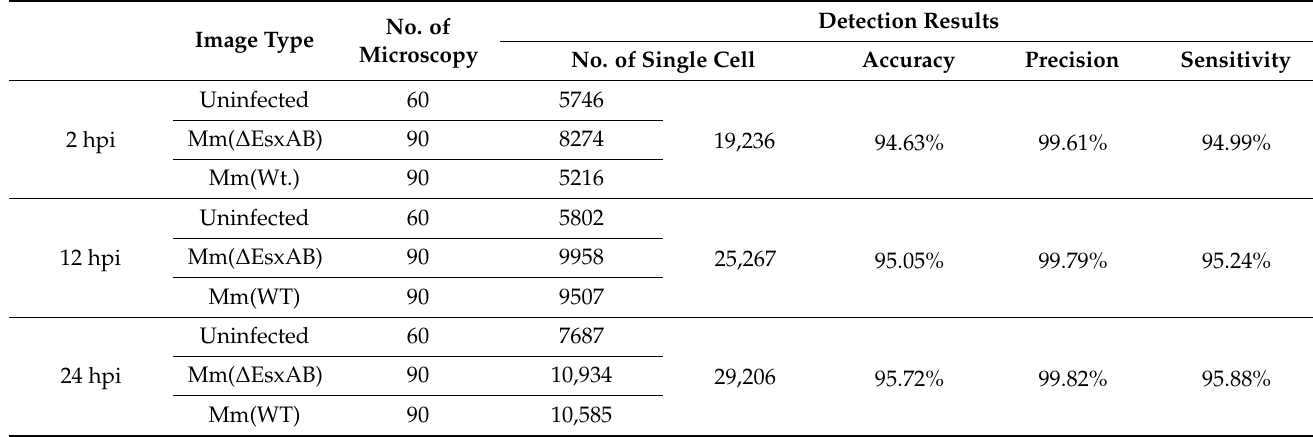
Table 3. The detection results of Auto-AISDC for THP-1